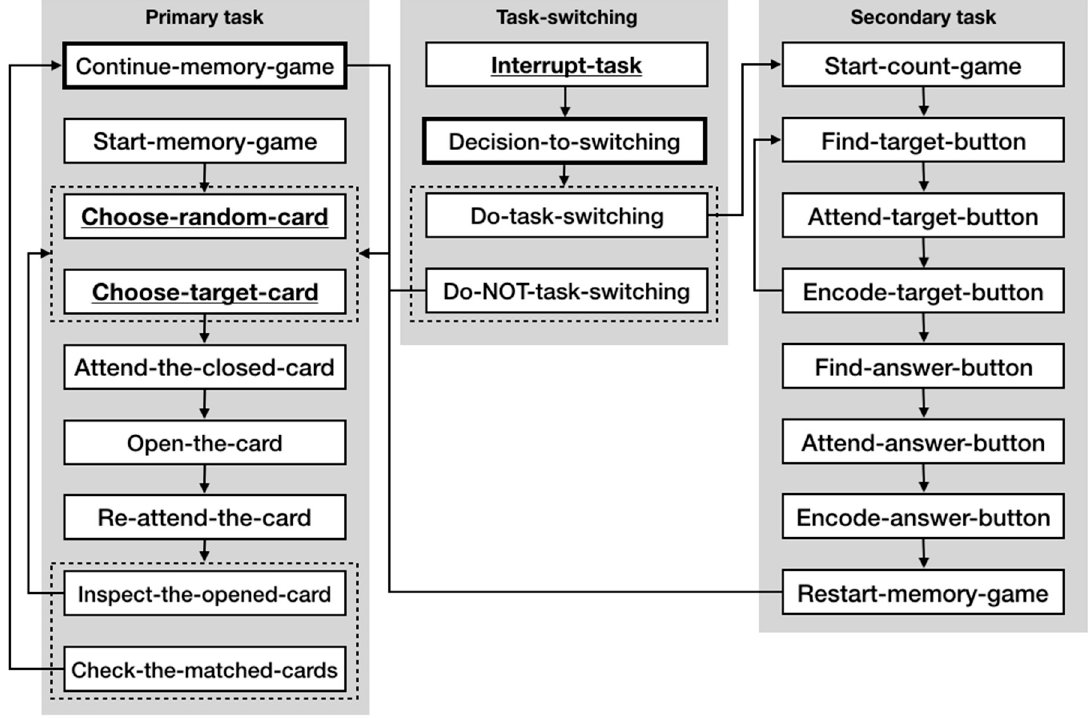
Figure 5. Symbolic structure of the illustrated model.